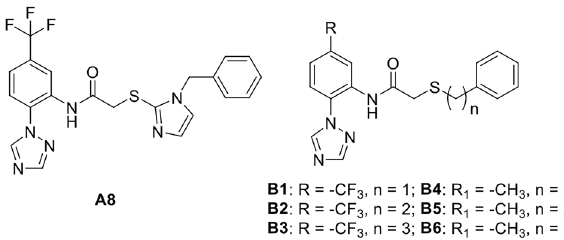
Figure 4. Structures of A8 and the related synthesized compounds B1-6.